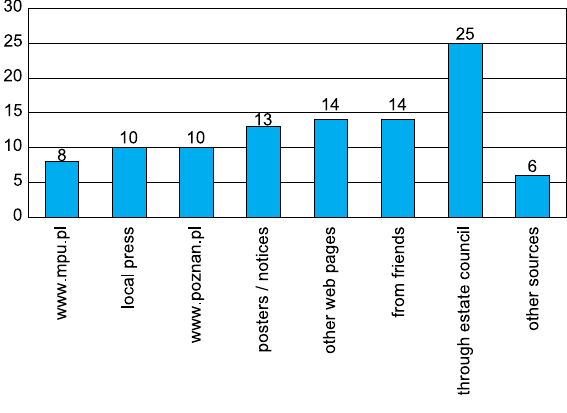
Fig. 5. Sources of information about public consultations. Source: own